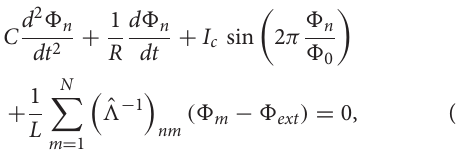
shown in Figure 4A . A typical chaotic attractor of the SQUID is φ phase plane in Figure 4B for (cid:127) shown on the φ − ˙